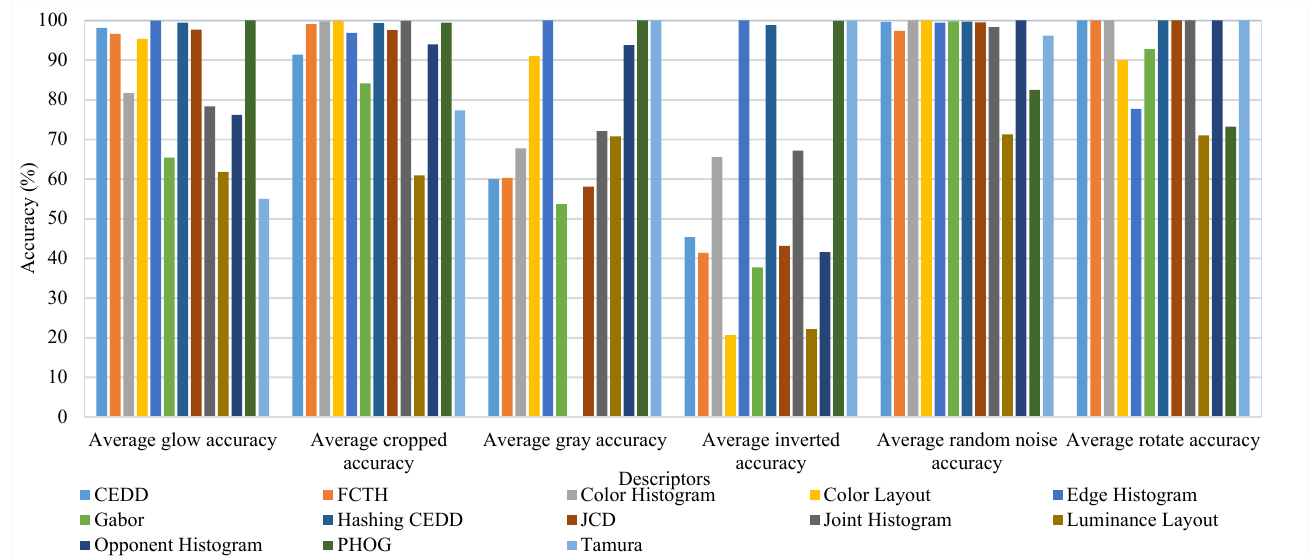
Figure 21. Comparing all descriptors from a viewpoint which relates all filters per descriptor.